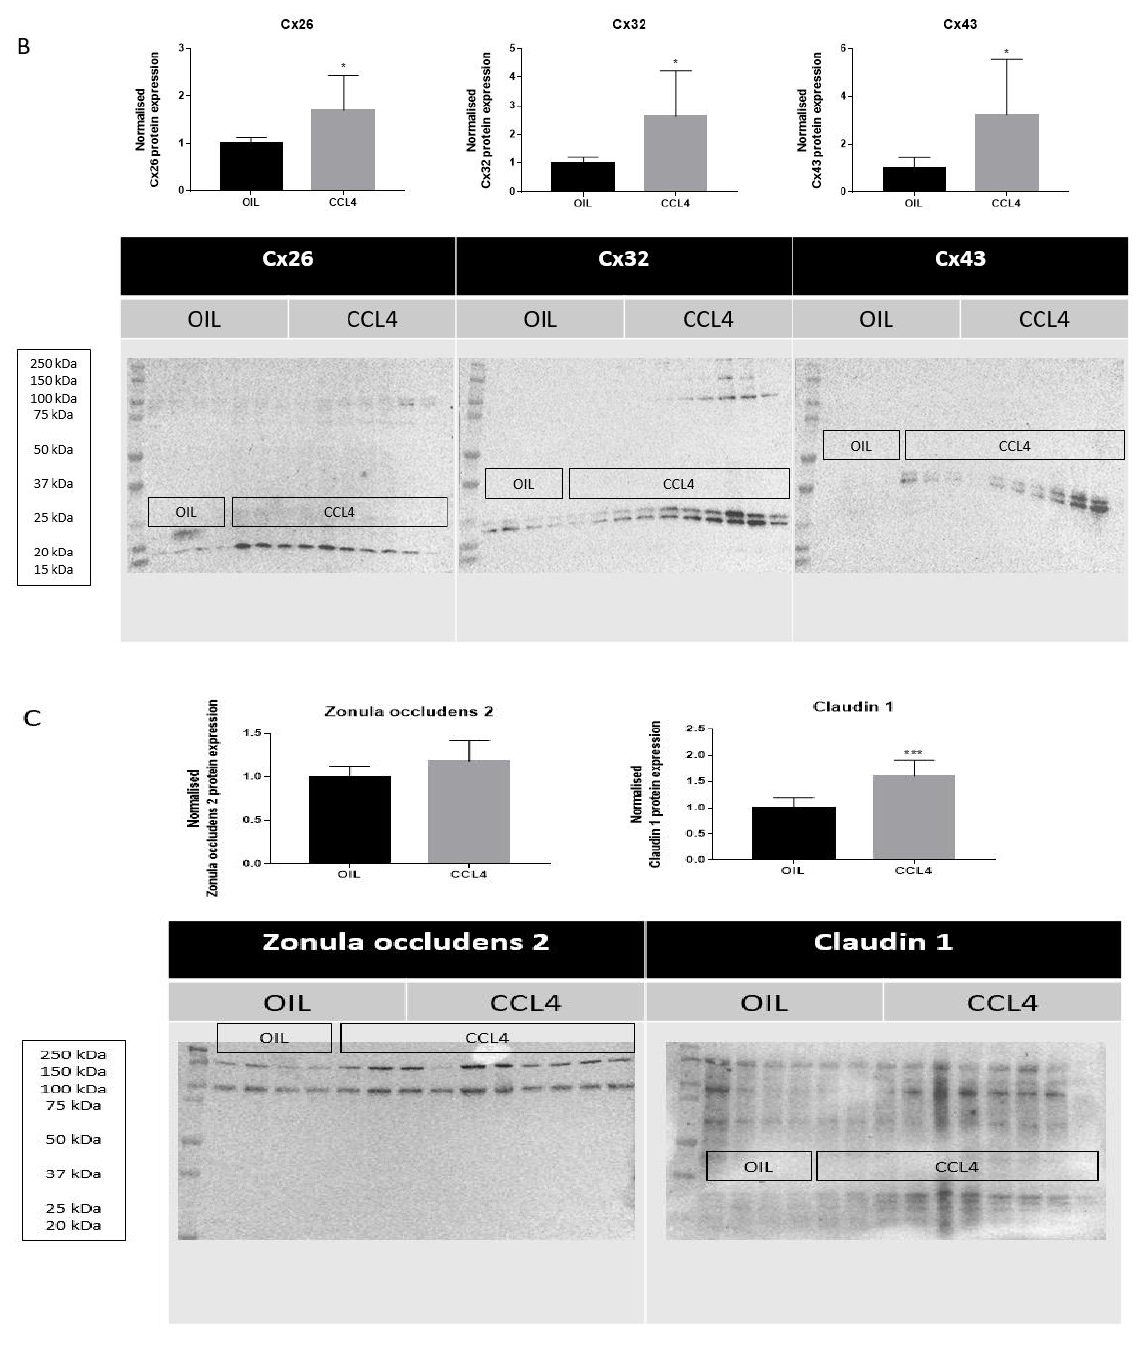
Figure 3: Effects of chronic liver disease on protein levels of hepatic cell junction components. Mice received injections with OIL or CCL4 for 8 weeks. Hepatic protein levels of E-cadherin, β-catenin, γ-catenin, Cx26, Cx32, Cx43, zonula occludens 2 and claudin 1 were assessed by immunoblot analysis, normalized against the total protein content and expressed as relative alteration compared to OIL- treated animals. Results were analyzed by 2-tailed unpaired student t-tests and Welch’s correction. Data were expressed as means ± SD (* p ≤ 0.05; *** p ≤ 0.001) ( n = 8-10; N =